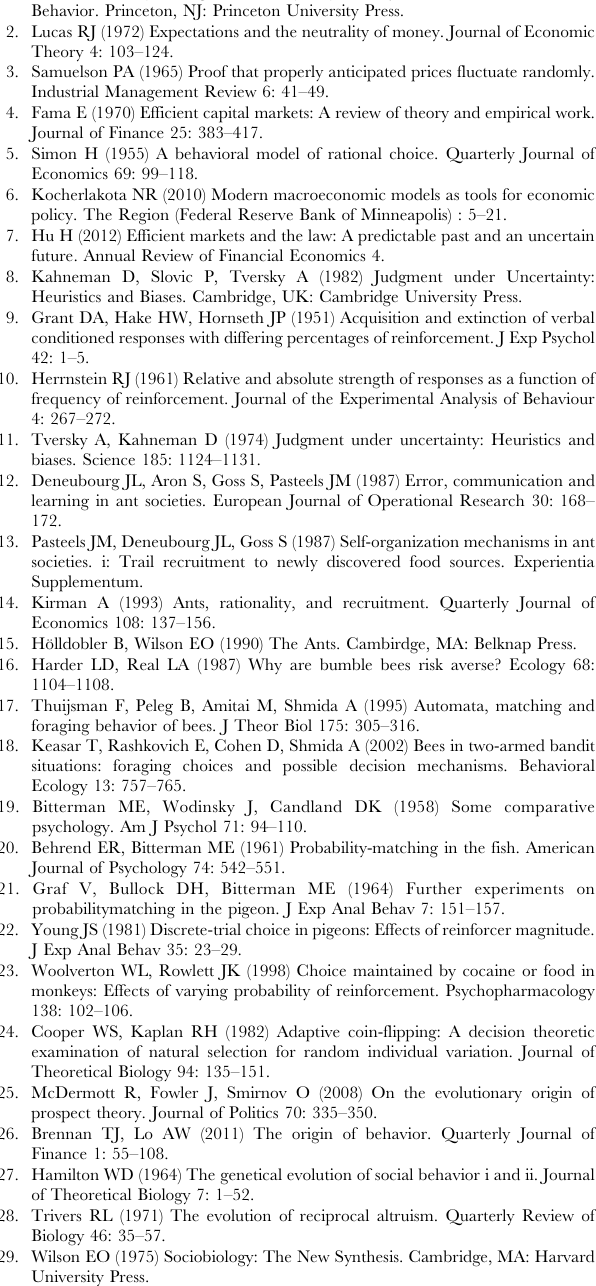
Text S1 Proofs and derivations of all the results in the main text are provided in this